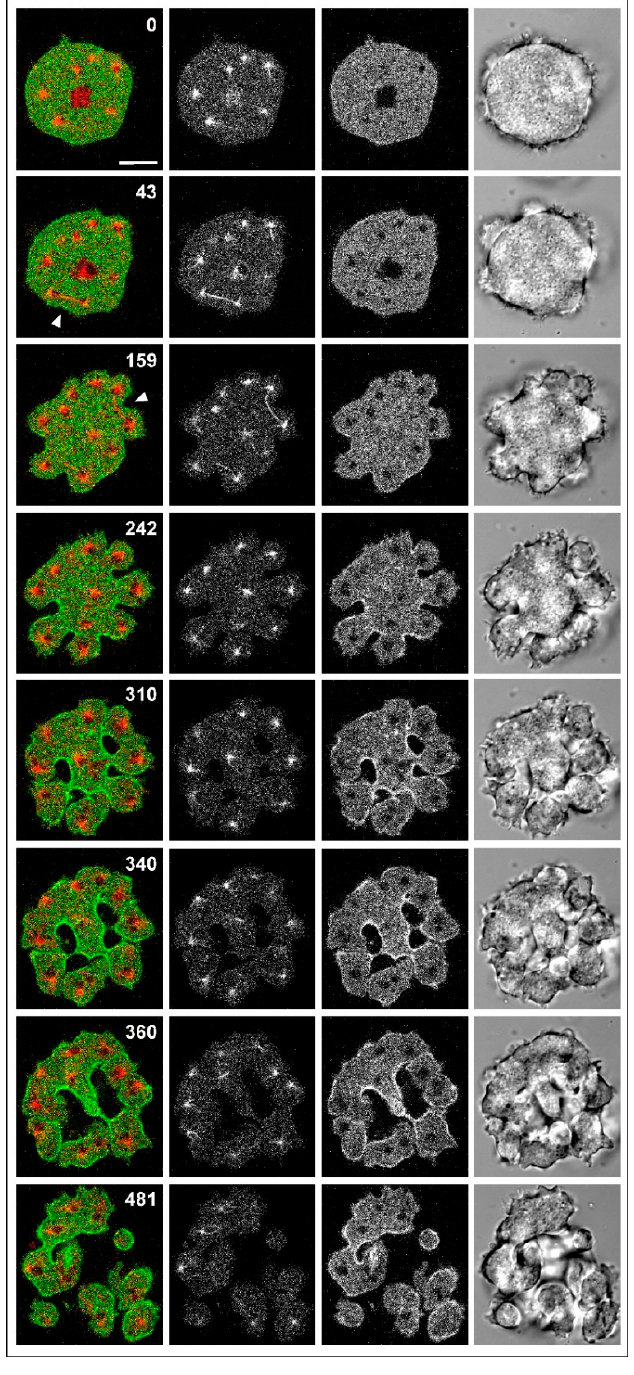
Figure 3. Unilateral furrows in a multinucleate wild-type cell produced by electric pulse-induced fusion. The cells fused expressed mRFP- α -tubulin (red) and GFP-myosin-II heavy chains (green in the merged panels). Confocal fluorescence images show the labels merged (left) but also separated (second row: α -tubulin; third row: myosin-II). On the right, DIC bright-field images are shown. In the merged panels, a straight spindle before furrow ingression and a spindle bent after the onset of furrowing are indicated by arrowheads. In the middle of the large cell, an interphase cell was apparently entrapped by accident (seen in the 0 and 43 s frames). Time is indicated in seconds after the first frame. Scale bar, 10 µ m. The entire time series from which these images were taken is covered in Supplementary Video S4.